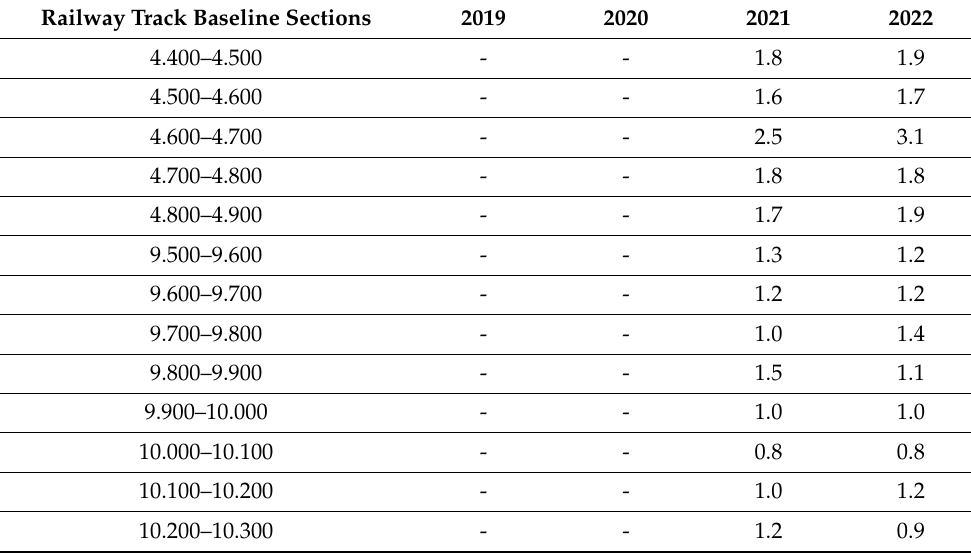
Table A5. Estimates of the railway track condition—absolute J , object No. R 161_2. Railway Track Baseline Sections